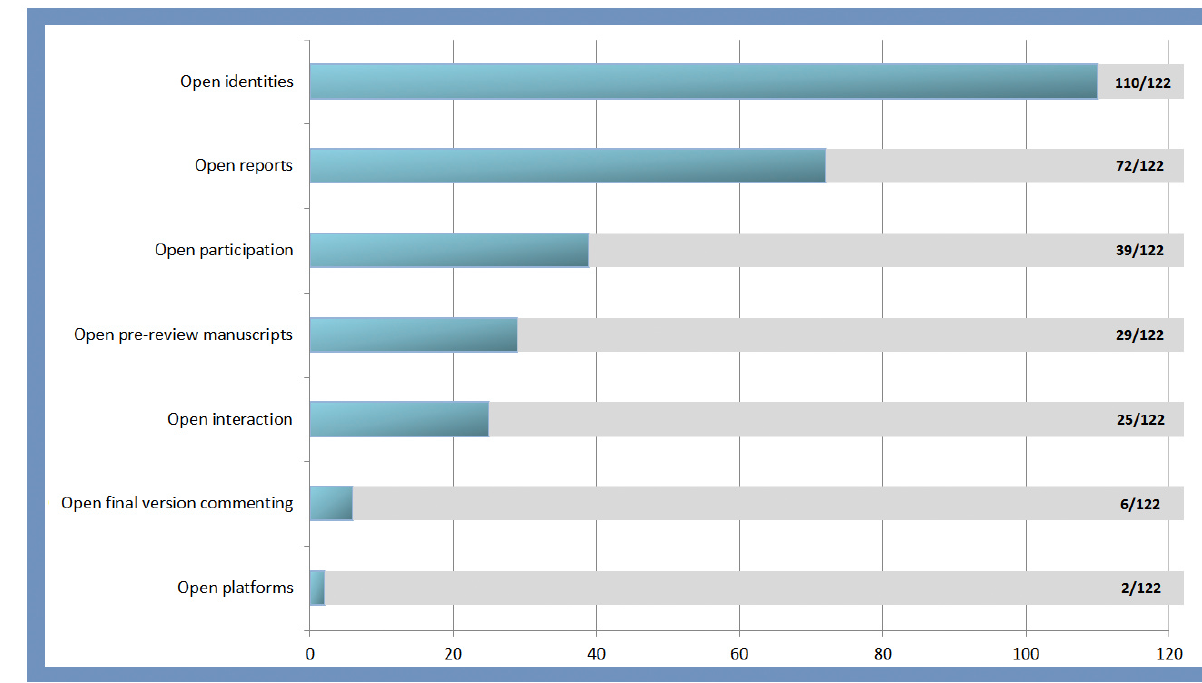
definition.Figure 5. Distribution of OPR traits amongst